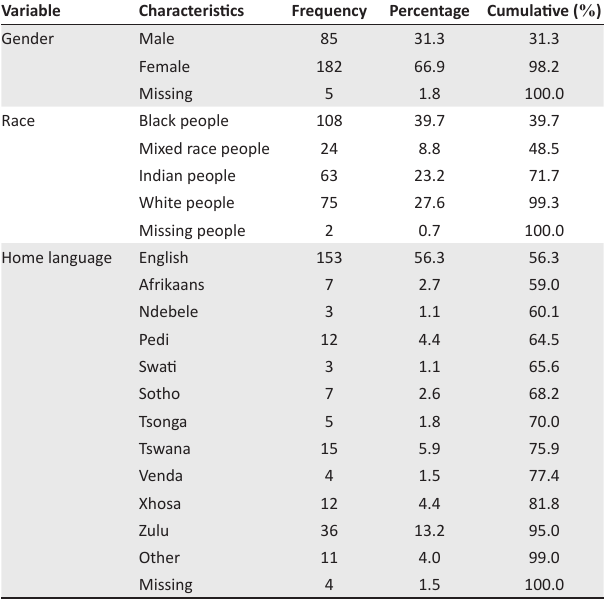
TABLE 1: Descriptive statistics for the sample. Variable